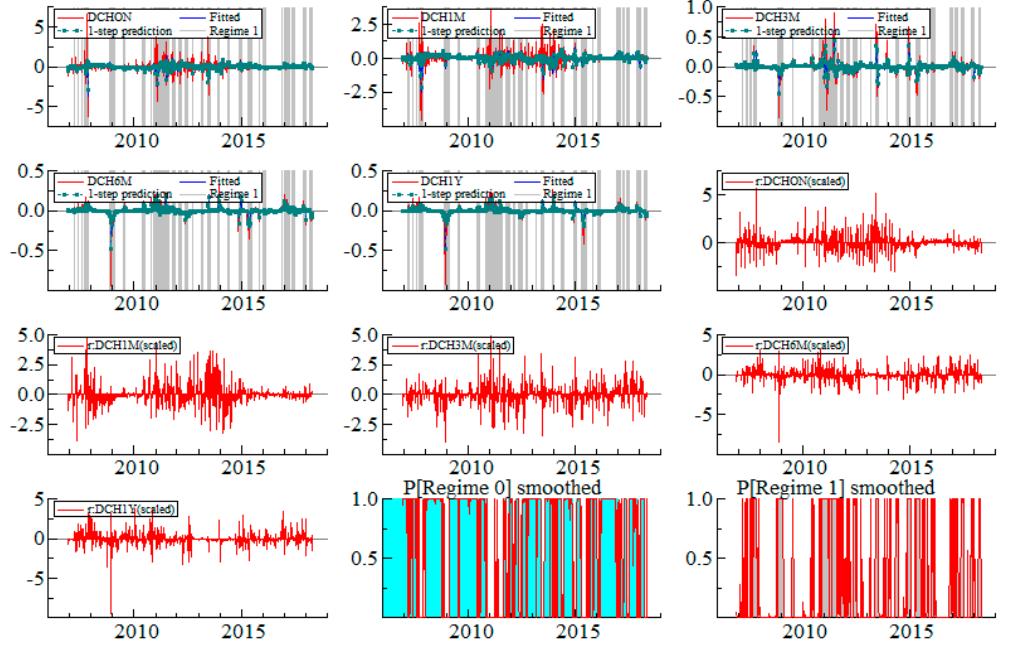
Figure A8. China Regime-switching modeling: Msiah (2)-Vecm (1). Note: Regime 1 denotes the high-volatility regime, whilst Regime 0 the low-volatility one [8,25].